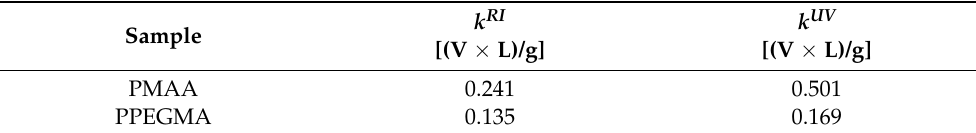
Figure 2. Above: Chromatogram of PMAA ( a ) and PPEGMA ( b ) homopolymers. These correspond, respectively to C/E values of ∞ and 0. The signals from RI and UV detector are plotted against the elution volume. Below: Determination of response factors in RI and UV detection of PMAA ( c ) and PPEGMA ( d ) by linear regression. The results of the linear regressions are shown in Table 2. Table 2. Response factors for PMAA and PPEGMA. The UV response factors were determined for a detection wavelength of 220